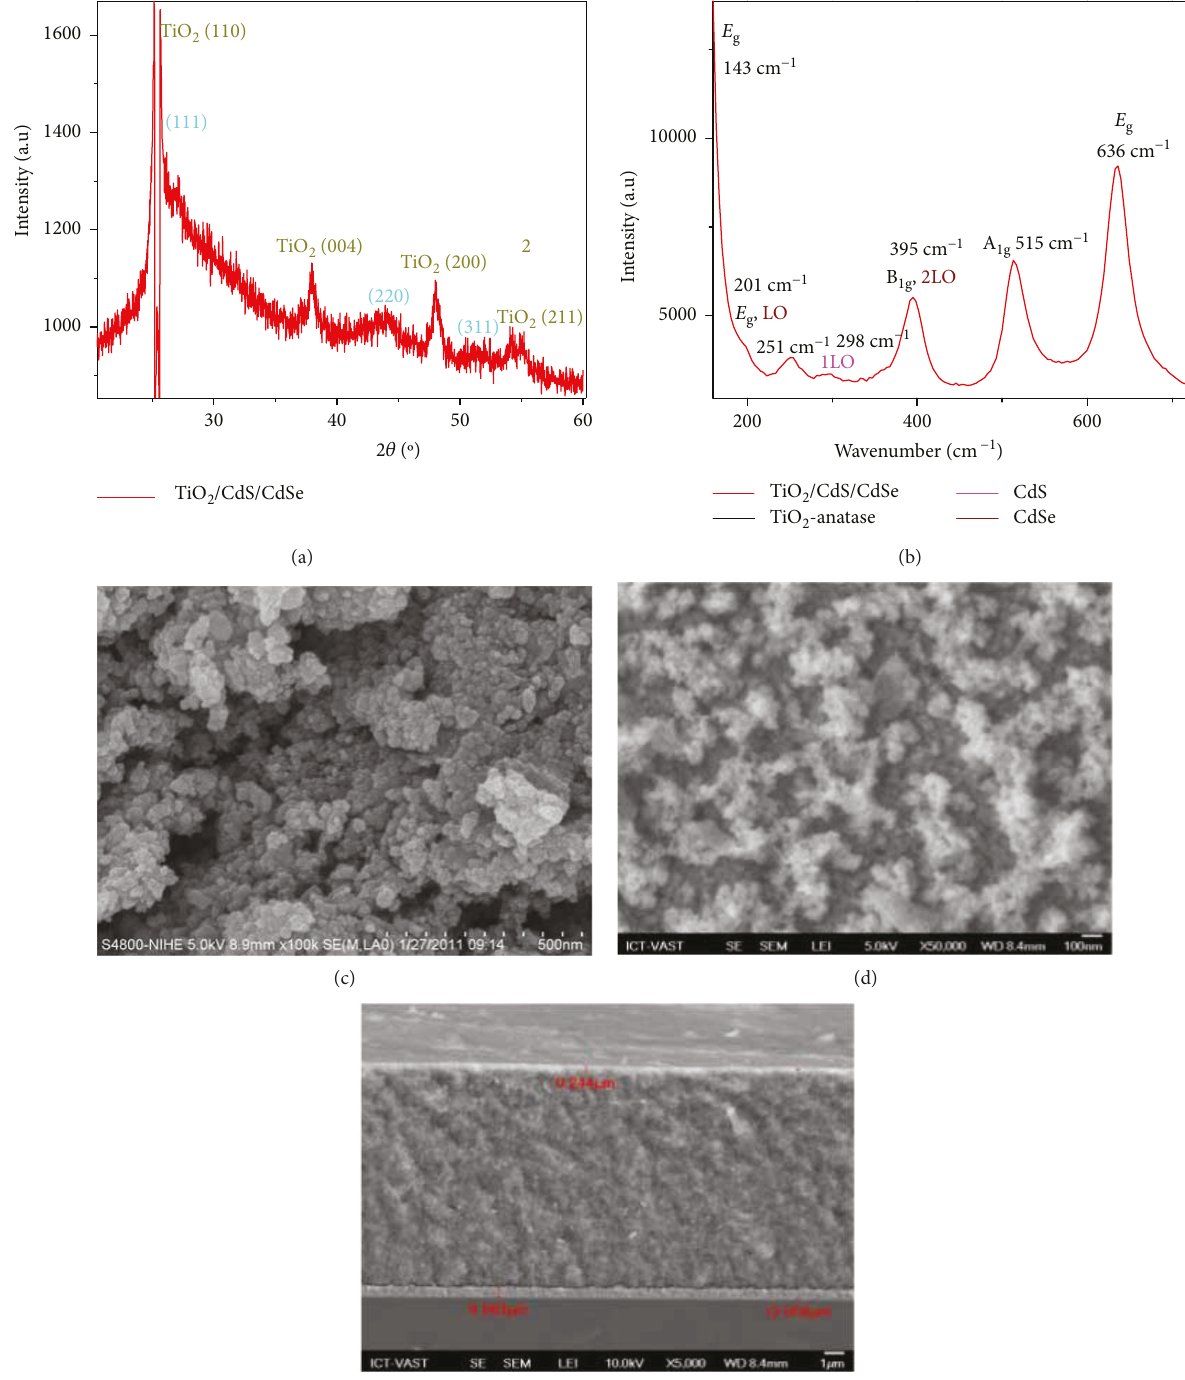
fi lm, (d) FESEM images of the 2